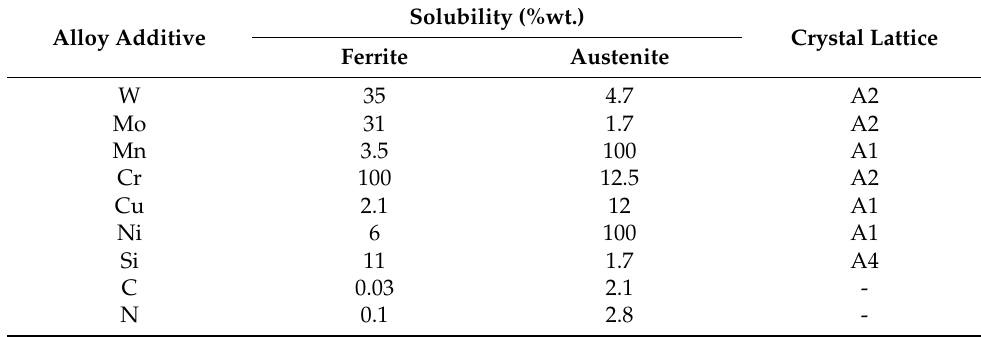
Table 1. Maximum solubility of alloy additives in ferrite and austenite (according to [26]). Solubility (%wt.) Alloy Additive